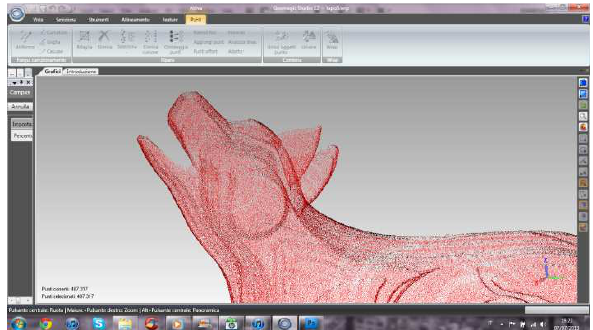
Figure 16. The point cloud of the Wolf of Sila, obtained with a scan of T.O.F. laser scanner